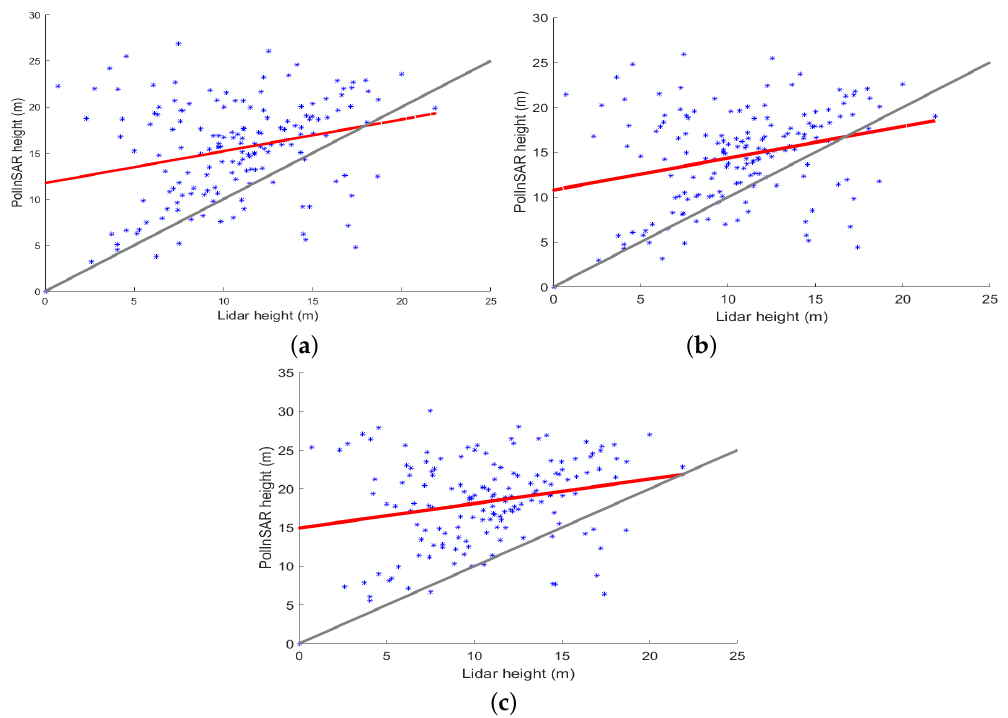
Figure 8. Relation (in red) between PolInSAR height resulting from ( a ) the RVoG model ( R 2 = 0.50, RMSE = 0.67 m), ( b ) the RMoG model ( R 2 = 0.69, RMSE = 0.60 m), and ( c ) the RMoG L model ( R 2 = 0.78, RMSE = 0.55 m) with the corresponding averaged height values from Lidar. The black line presents 1:1 line.